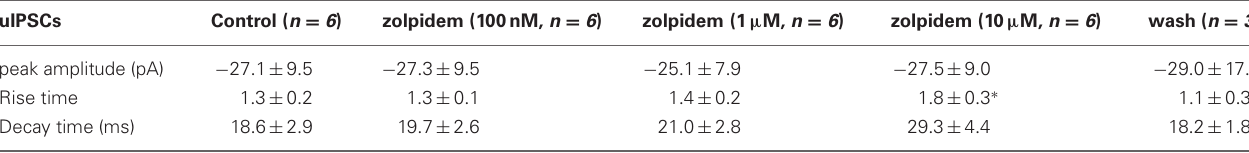
Table 2 | Effects of zolpidem (100nM, 1 μ M, and 10 μ M) on uIPSCs recorded from Imp paired recordings experiments.